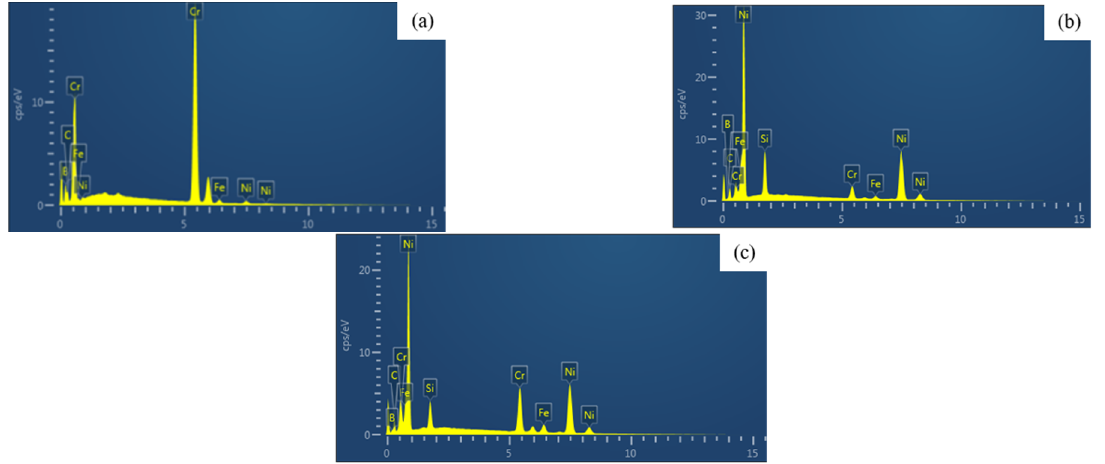
Figure 8. EDS patterns of the crack fracture in Figure 7c: ( a ) hard Cr-rich precipitates; ( b ) (cid:2011) , (Ni) ; ( c ) eutectic and amorphous phases. Table 2. Chemical compositions corresponding to Figure 8 (wt.%).